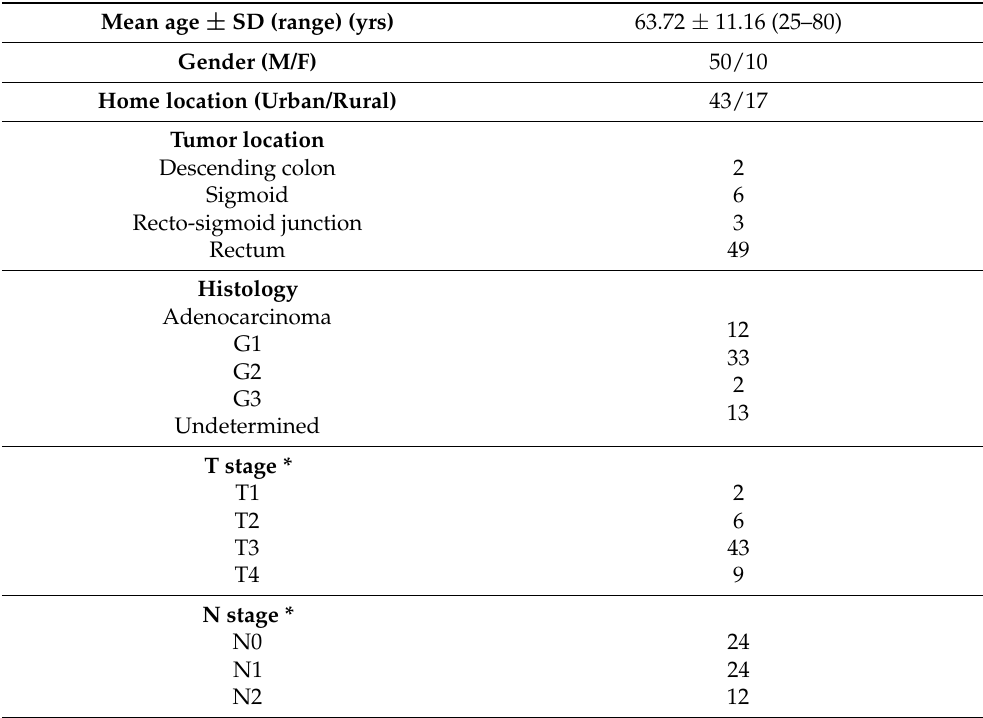
Table 5. Patient